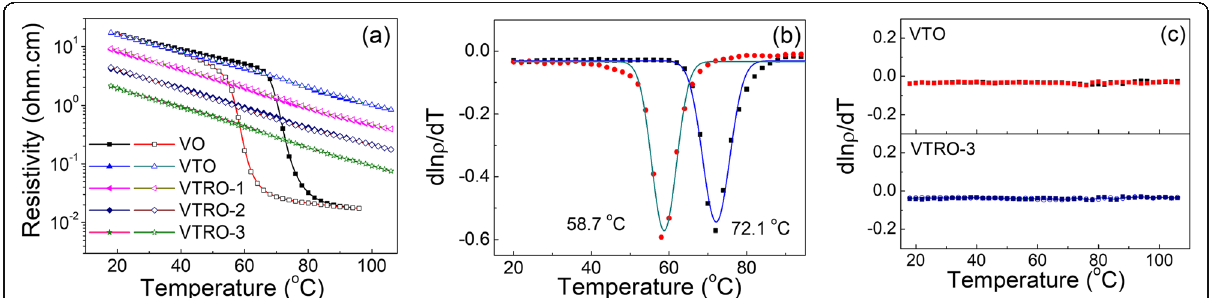
Fig. 6 a Temperature dependence of ρ for all the samples, plots of dln ρ /dT vs. T for b VO and c VTO and